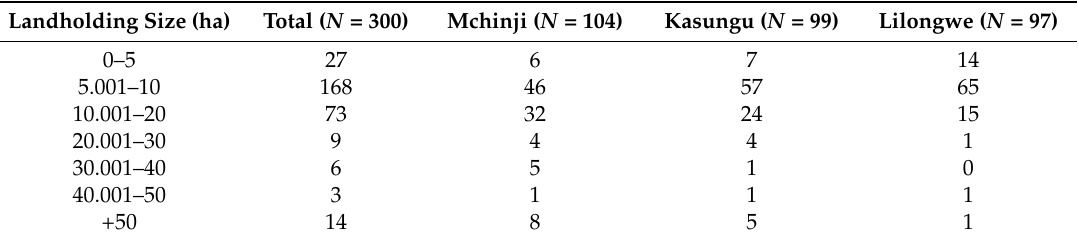
Table 1. Farming households interviewed in the framework of this research. Landholding Size (ha) Total ( N = 300) Mchinji ( N = 104)